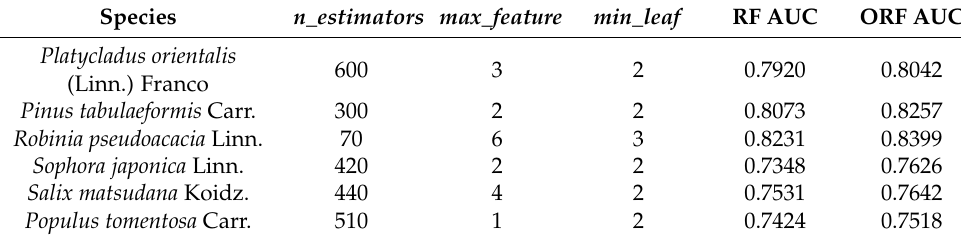
Table 6. Model parameters and validation accuracy.